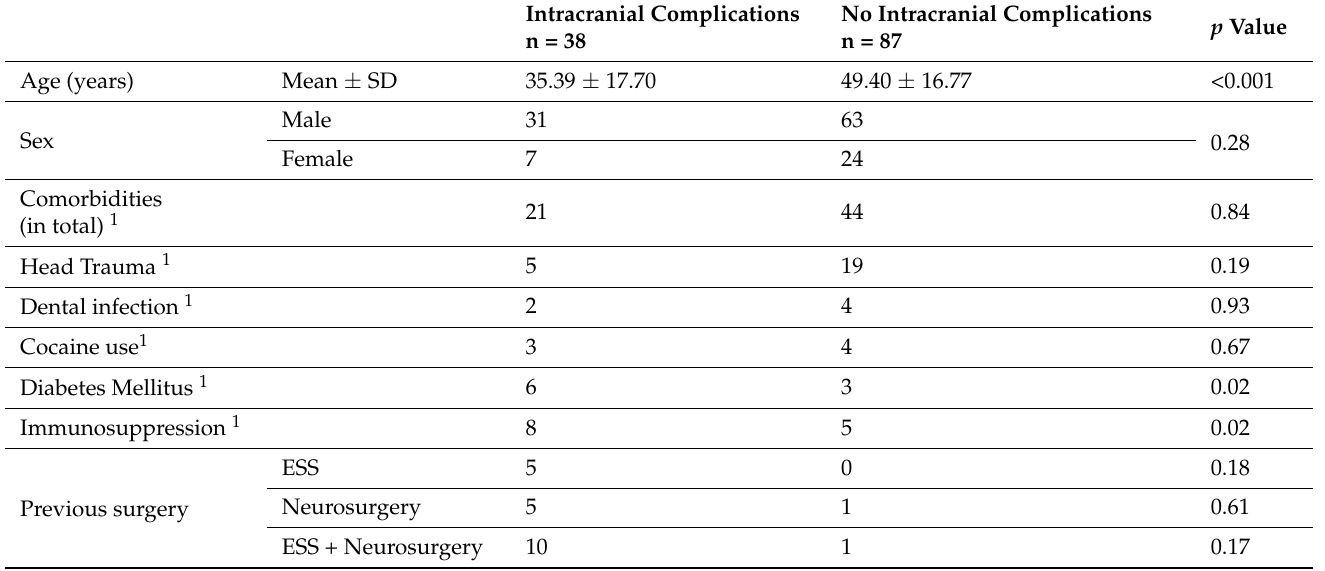
Table 3. Correlation of demographics, medical history, and microbiology findings between adult PPT patients with and without intracranial